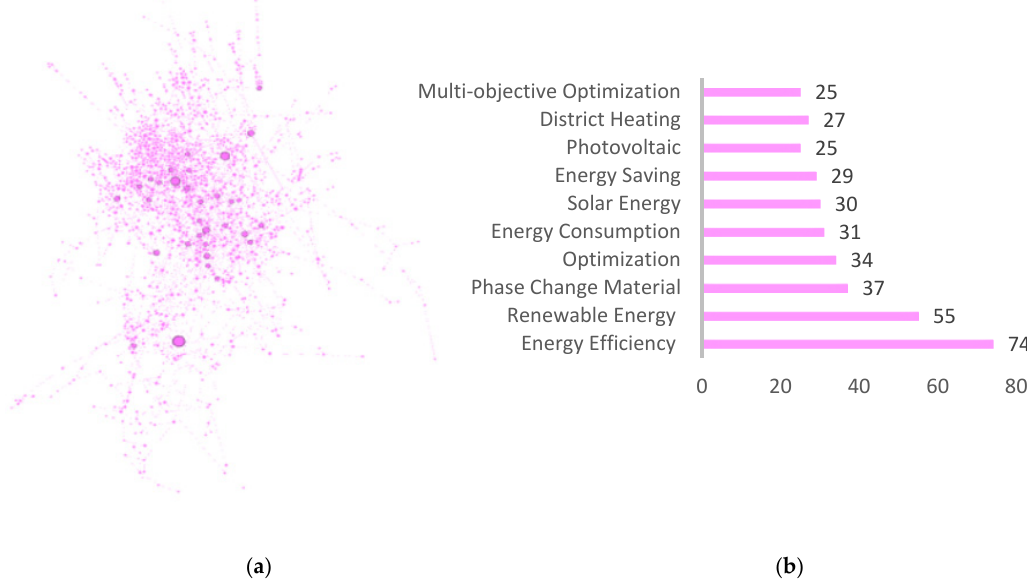
Figure 13. Climate change–electric energy: ( a ) manuscripts published, ( b ) keywords.